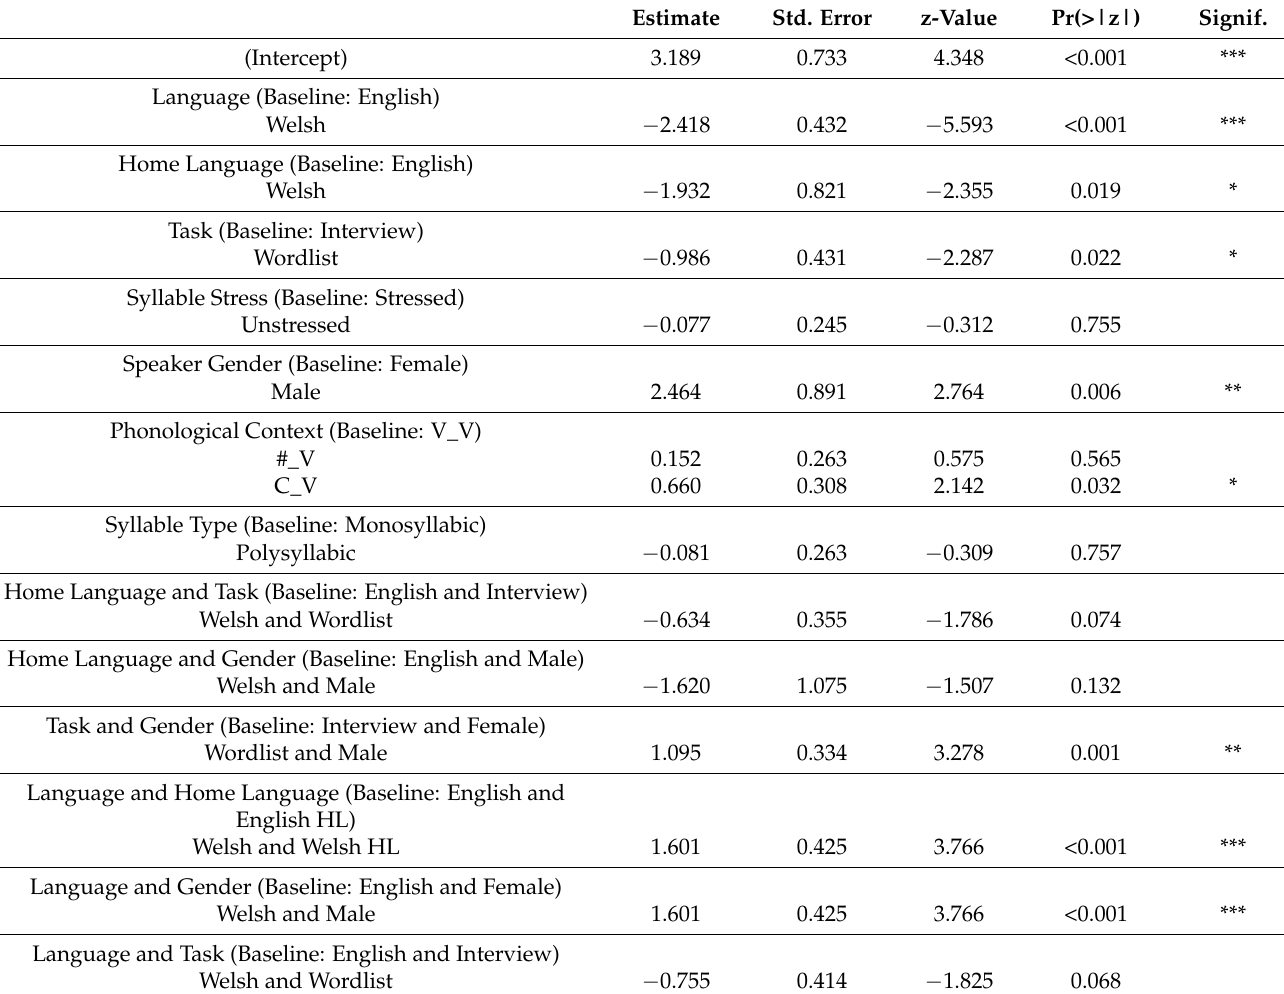
Table A1. Regression coefficients with z - and p -values for the final model predicting the production of the alveolar approximant in Caernarfon ( n = 1558). Positive estimates indicate an increased likelihood of the alveolar approximant. AIC = 1350.7. Estimate Std. Error z-Value Pr(>|z|) Signif. (Intercept) 3.189 0.733 4.348